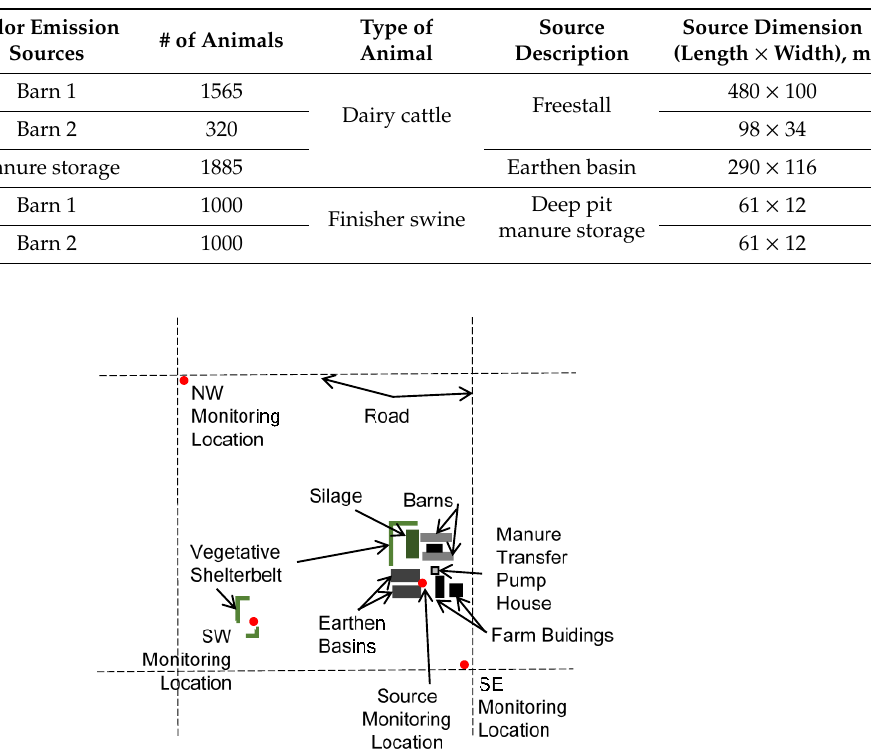
Table 1. General description of the sites.